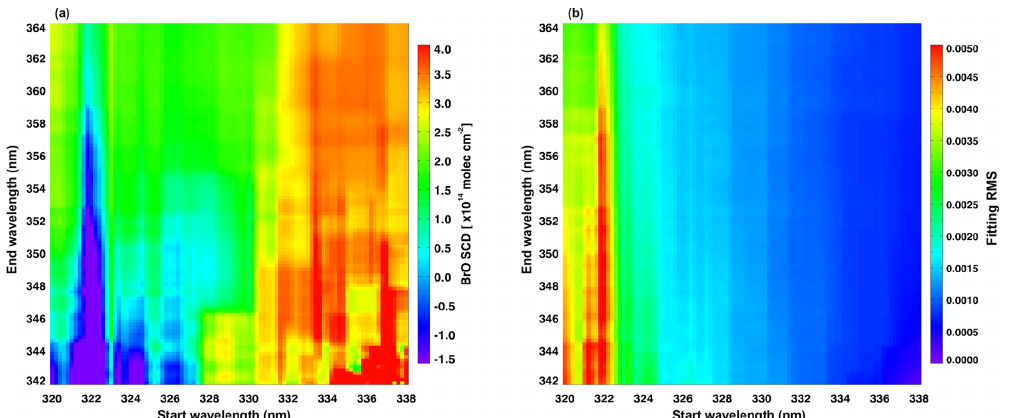
Figure A1. Color-coded means of (a) BrO SCDs and (b) fitting rms values retrieved when including the Taylor series approach for O 3 in the DOAS analysis.